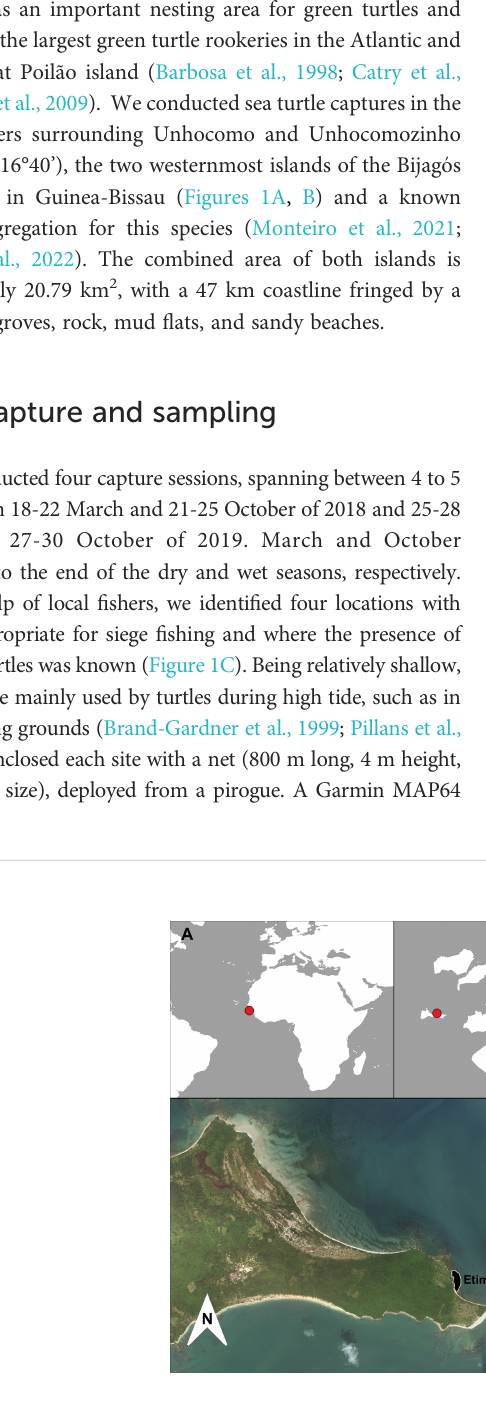
FIGURE 1 (A, B) Relative location of Unhocomo and Unhocomozinho islands in the Bijago ́ s, Guinea-Bissau. (C) Sampled green turtle foraging sites, with respective area name, color labeled by habitat type: black – rocky-bottom; orange –